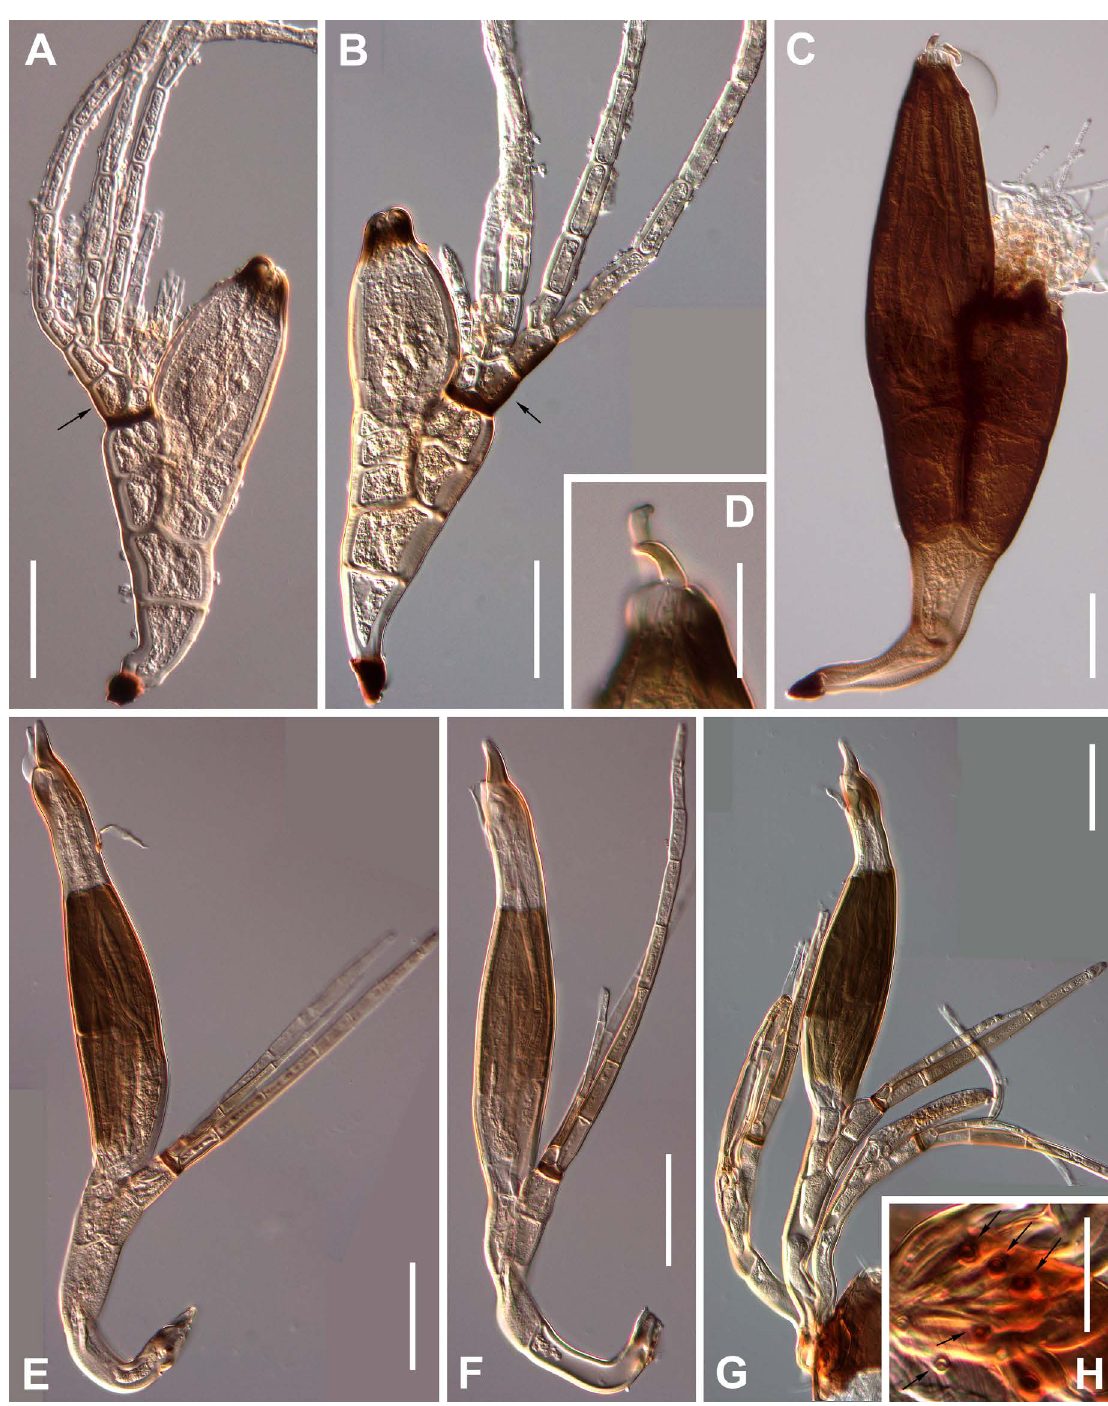
Fig. 33. Laboulbenia spp. A – B . L. giardii Cépède & F.Picard. Mature thalli showing dark lower margin of outer appendage (arrows), a diagnostic character. – C – D . L. gyrinicola Speg. C . Mature thallus. D . Perithecial apex with outgrowths in detail. – E – H . L. hyalopoda De Kesel. E – F . Mature thalli. G . Mature thallus accompanied by two young thalli. H . Dark rings (arrows) belonging to the feet of several thalli. Scale bars: A–C, E–G = 50 µm; D, H = 25 µm. Photographs from slides ZMUC C-F-122561 (A–B), ZMUC C-F-123665 (C), ZMUC C-F-123698 (D), ZMUC C-F-122889 (E–F, H), ZMUC C-F-122629